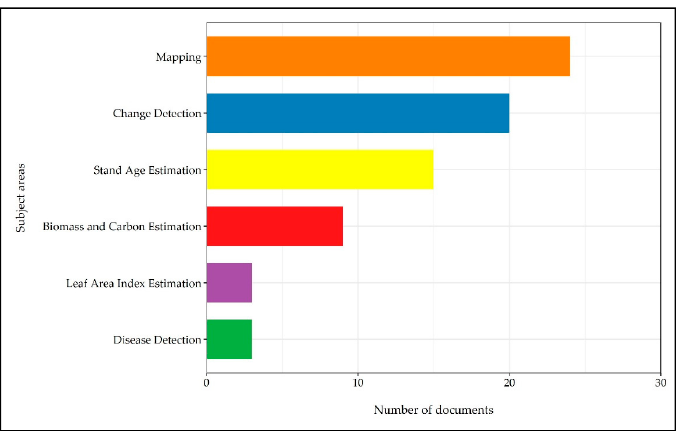
Figure 6. Distribution of the selected documents in each subject area.